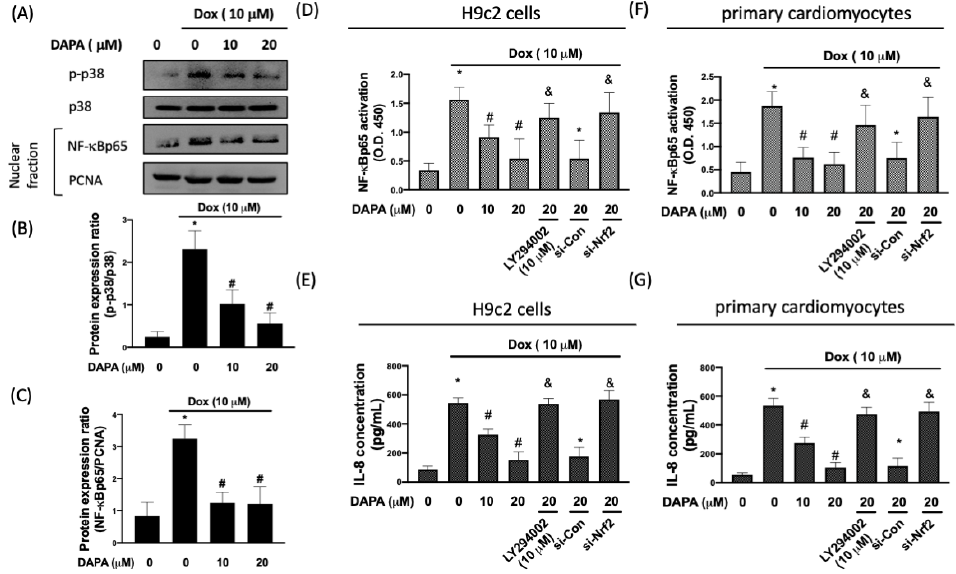
Figure 6. DAPA treatment suppresses the production of Dox-induced inflammatory mediators. Representative Western blot images ( A ) and densitometric analysis of phospho-p38 ( B ) and NF- κ B p65 ( C ) in Dox-stimulated H9c2 cells with various concentrations of DAPA treatment were shown. NF- κ B p65 activation ( D ) and IL-8 production ( E ) in Dox-treated H9c2 cells with various concentrations of DAPA treatment were examined by ELISA assay. LY294002 (a PI3K inhibitor) and si-Nrf2 were used in some experiments. The finding of NF- κ B p65 activation ( F ) and IL-8 production ( G ) were conducted in primary cardiomyocytes. Results are shown as means ± SD of three independent experiments. Statistical analysis was performed using one-way ANOVA with a Bonferroni post hoc test. [* p < 0.05 compared to the control group; # p < 0.05 compared to the Dox-only group; & p < 0.05 compared to Dox + DAPA group].